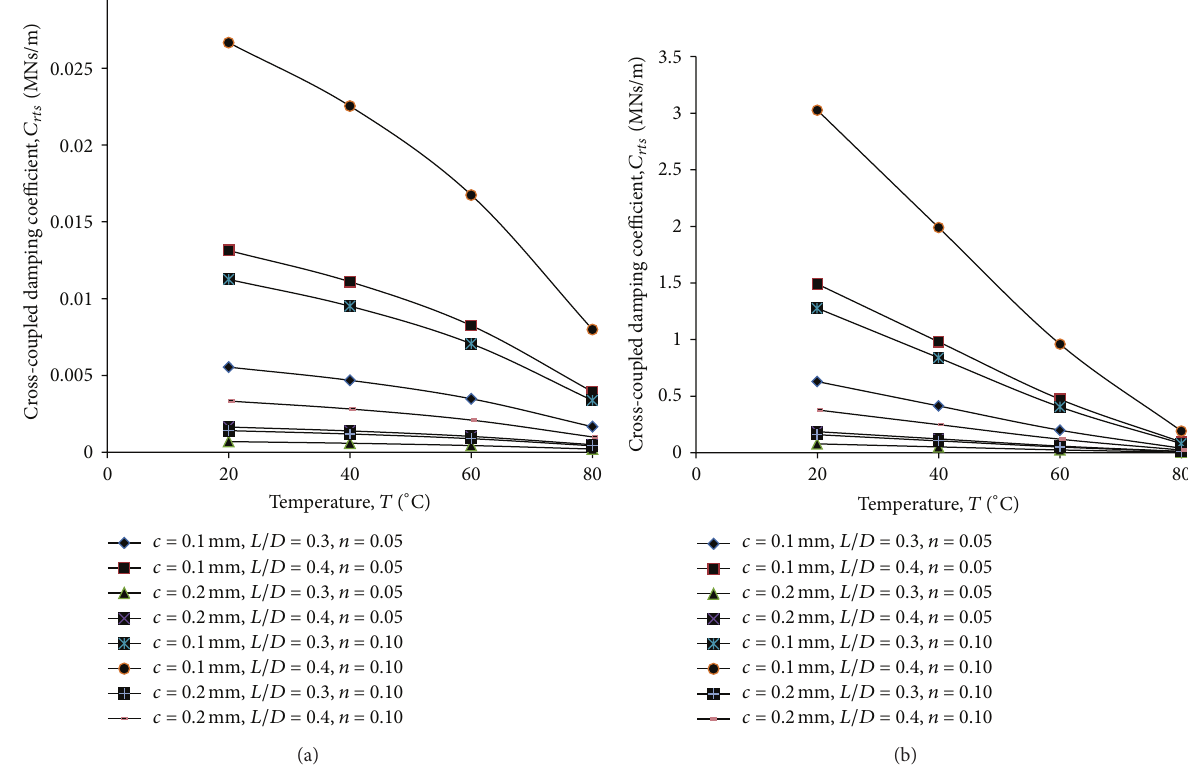
Figure 6: Cross-coupled damping coefficient, 𝐶 𝑟𝑡𝑠 , MNs/m versus temperature, ( ∘ C) for (a) 𝐸 = 0 kV/mm and (b) 𝐸 = 2.5 kV/mm under a constant strain rate, ̇𝛾 = 2 s −1 .